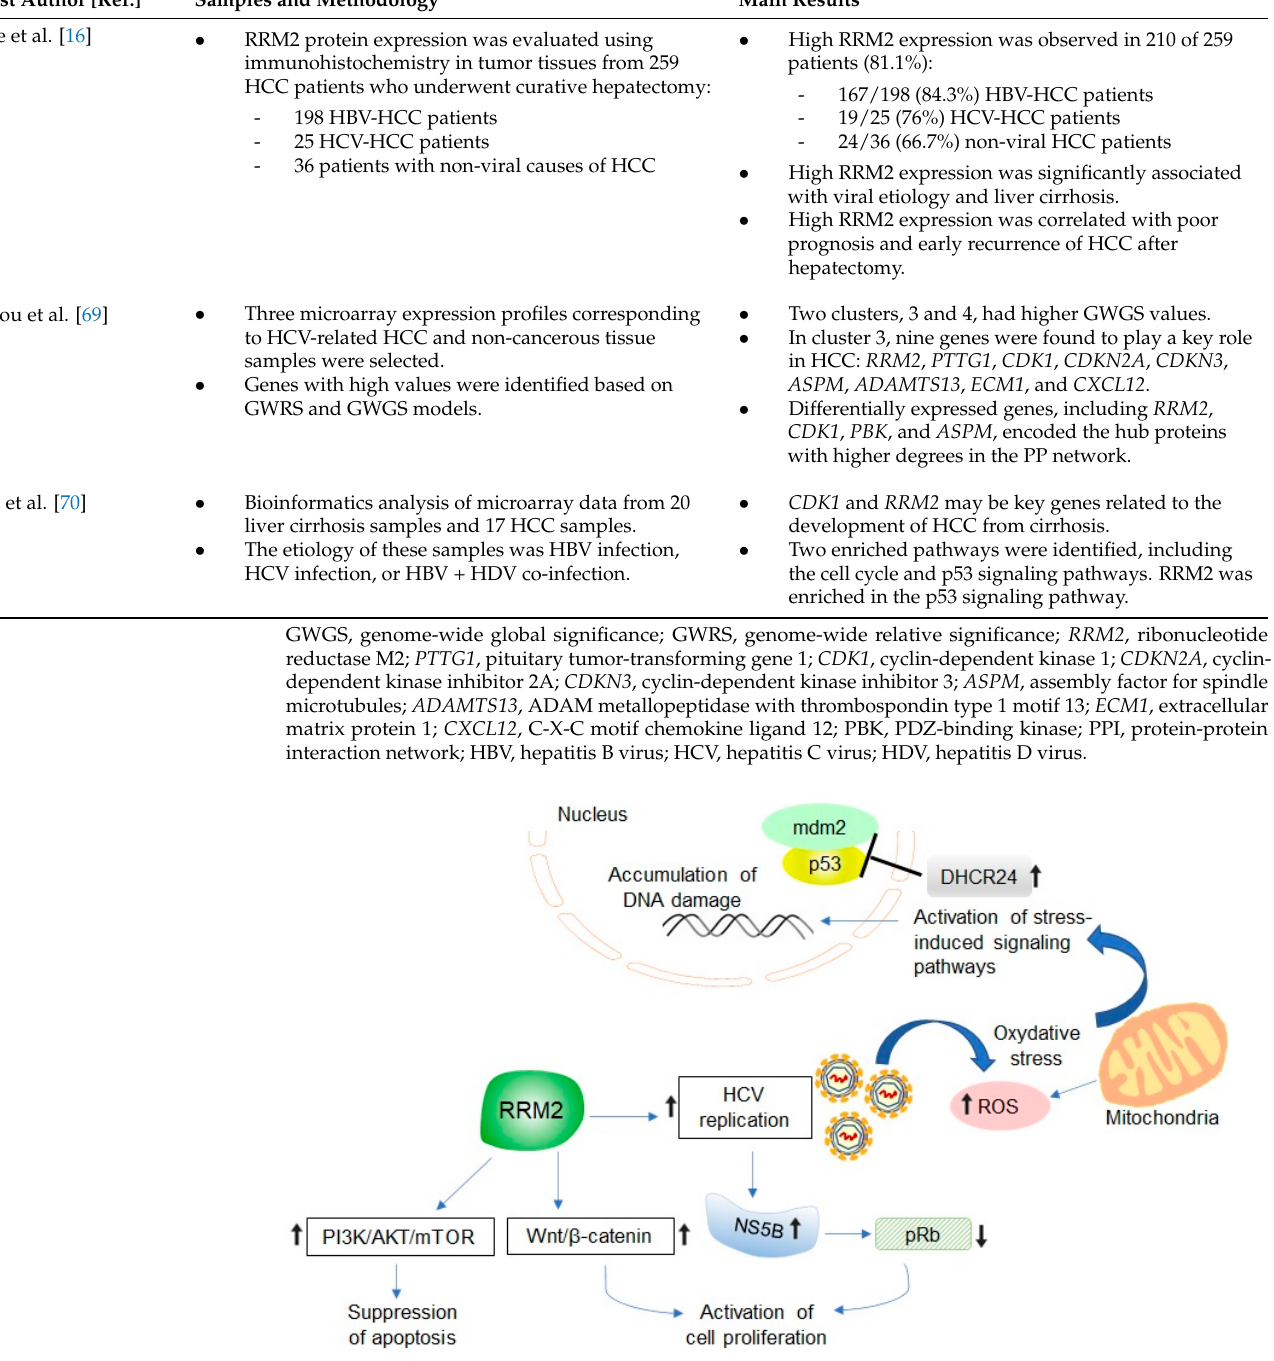
Figure 2. Schematic model of possible viral mechanisms and host signaling pathways induced by upregulated RRM2 expression and may contribute to HCV-associated liver tumorigenesis.